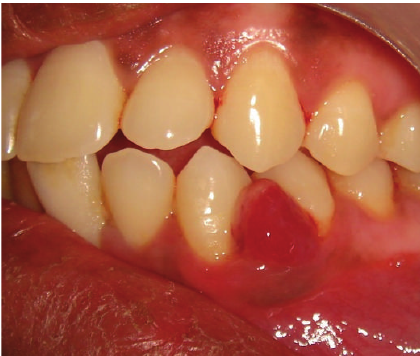
Figure 1: Exophytic and hemorrhagic lesion in the lower canine- premolar region (Buccal view).